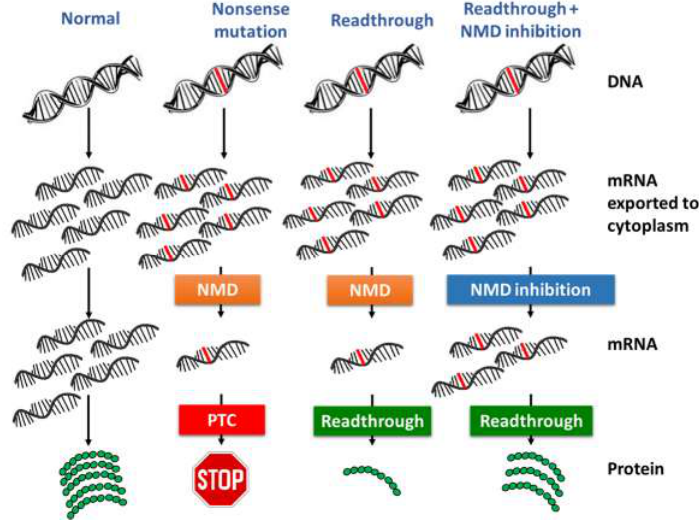
Figure 10. Comparison between protein syntheses from: a normally coded gene (left), a nonsense-mutated gene through normal NMD and codon recognition (center-left), a nonsense-mutated gene through normal NMD and active readthrough (center-right), and a nonsense-mutated gene with inhibited NMD and active readthrough (right).